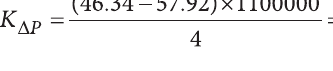
Fig. 1. Determination of accident-caused theoretical damage when using passenger cars with non-studded and studded tyres (Accumulation and renewal of traffi c data of the roads of national signifi cance,